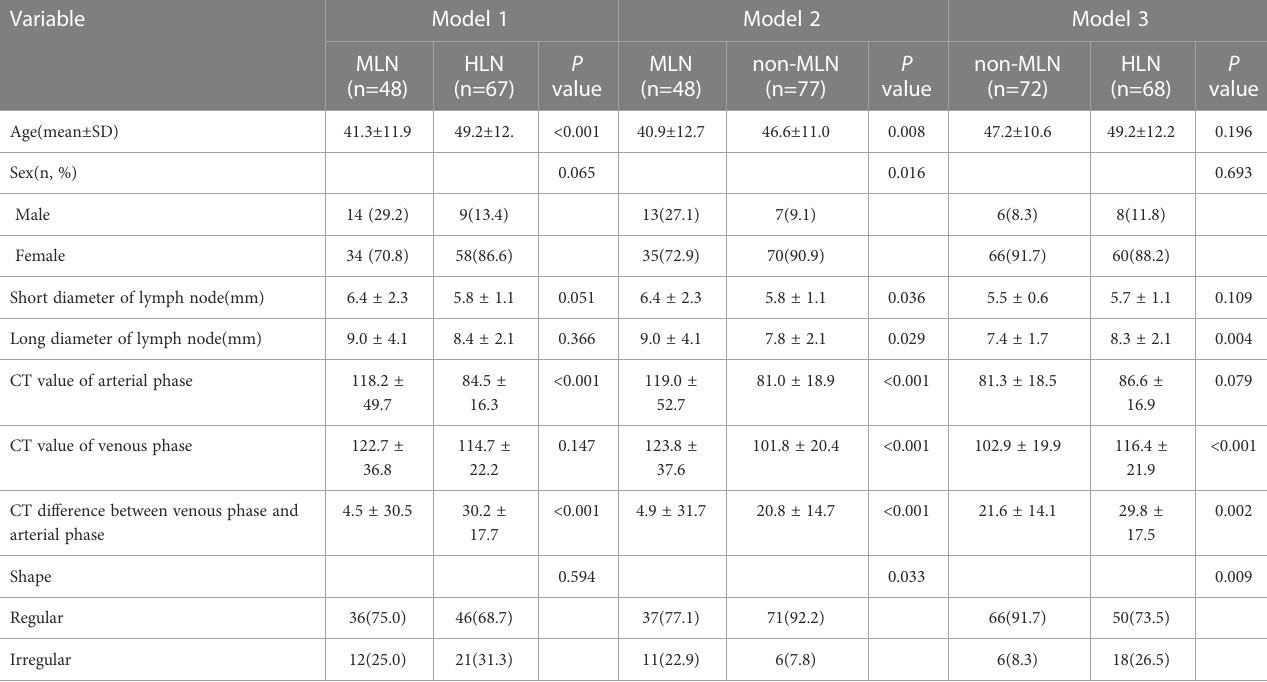
TABLE 1 Comparison of clinical characteristics of the three models in the training group.